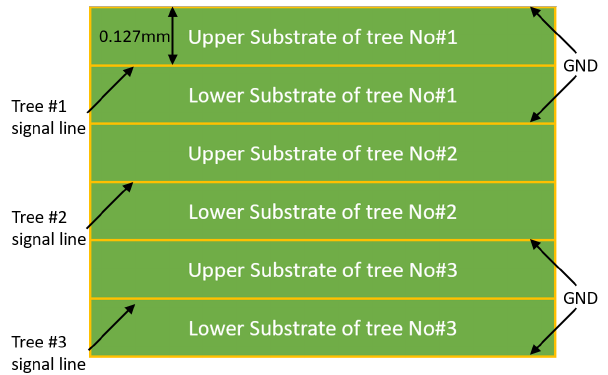
Figure 27. Cross section of the multilayer tree beamforming